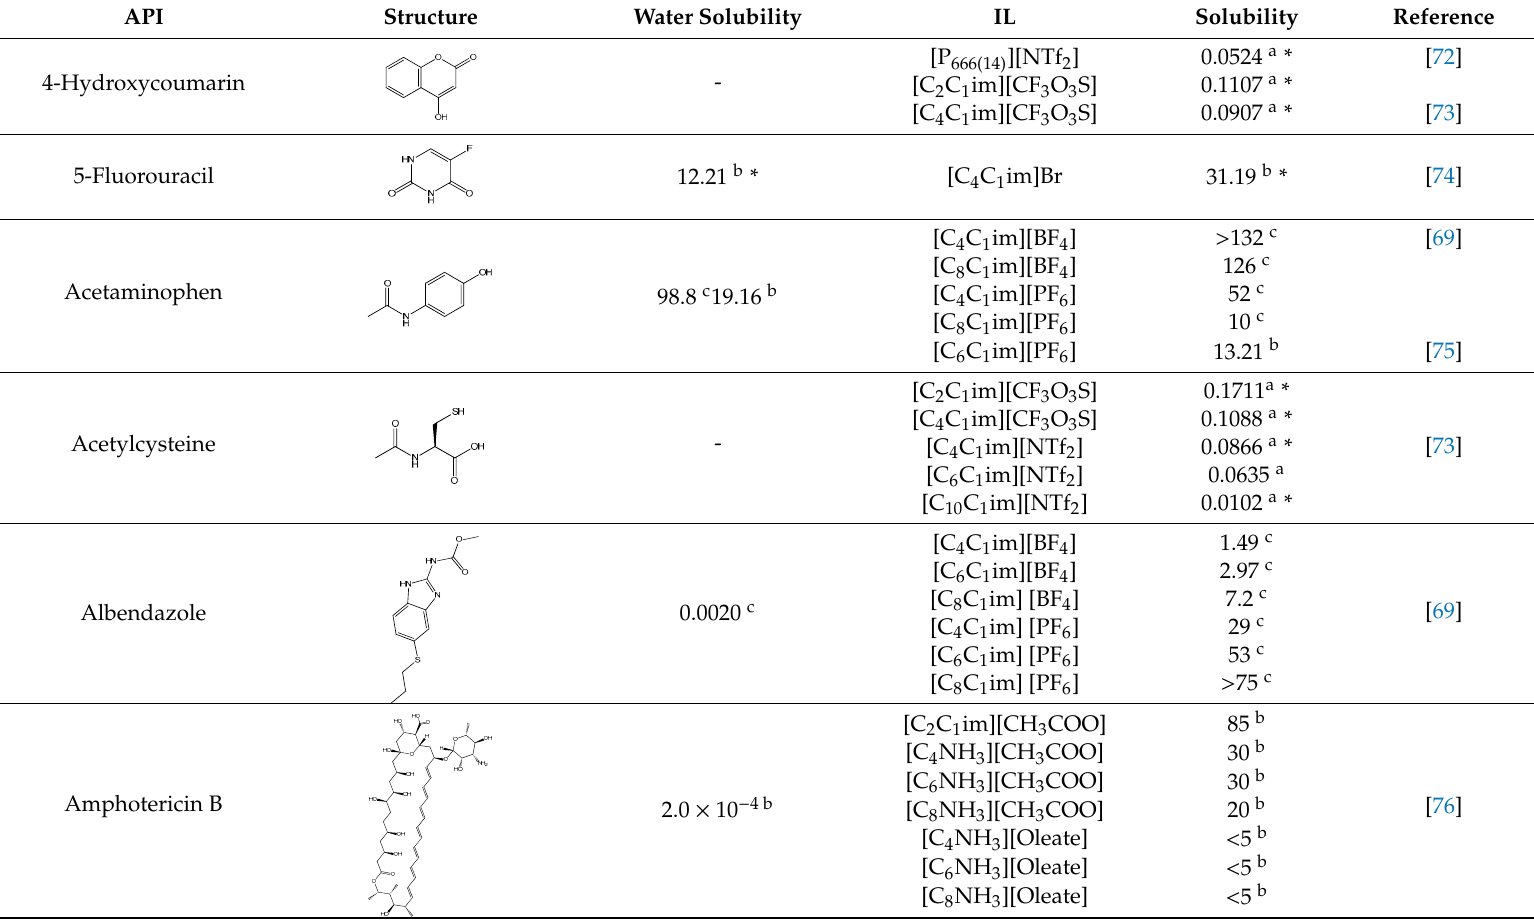
Table 1. Solubility of di ff erent APIs in selected ILs and comparison with their water solubility. Table 1. Solubility of different APIs in selected ILs and comparison with their water solubility. Table 1. Solubility of different APIs in selected ILs and comparison with their water solubility. Table 1. Solubility of different APIs in selected ILs and comparison with their water solubility. Table 1. Solubility of different APIs in selected ILs and comparison with their water solubility. Table 1. Solubility of different APIs in selected ILs and comparison with their water solubility.